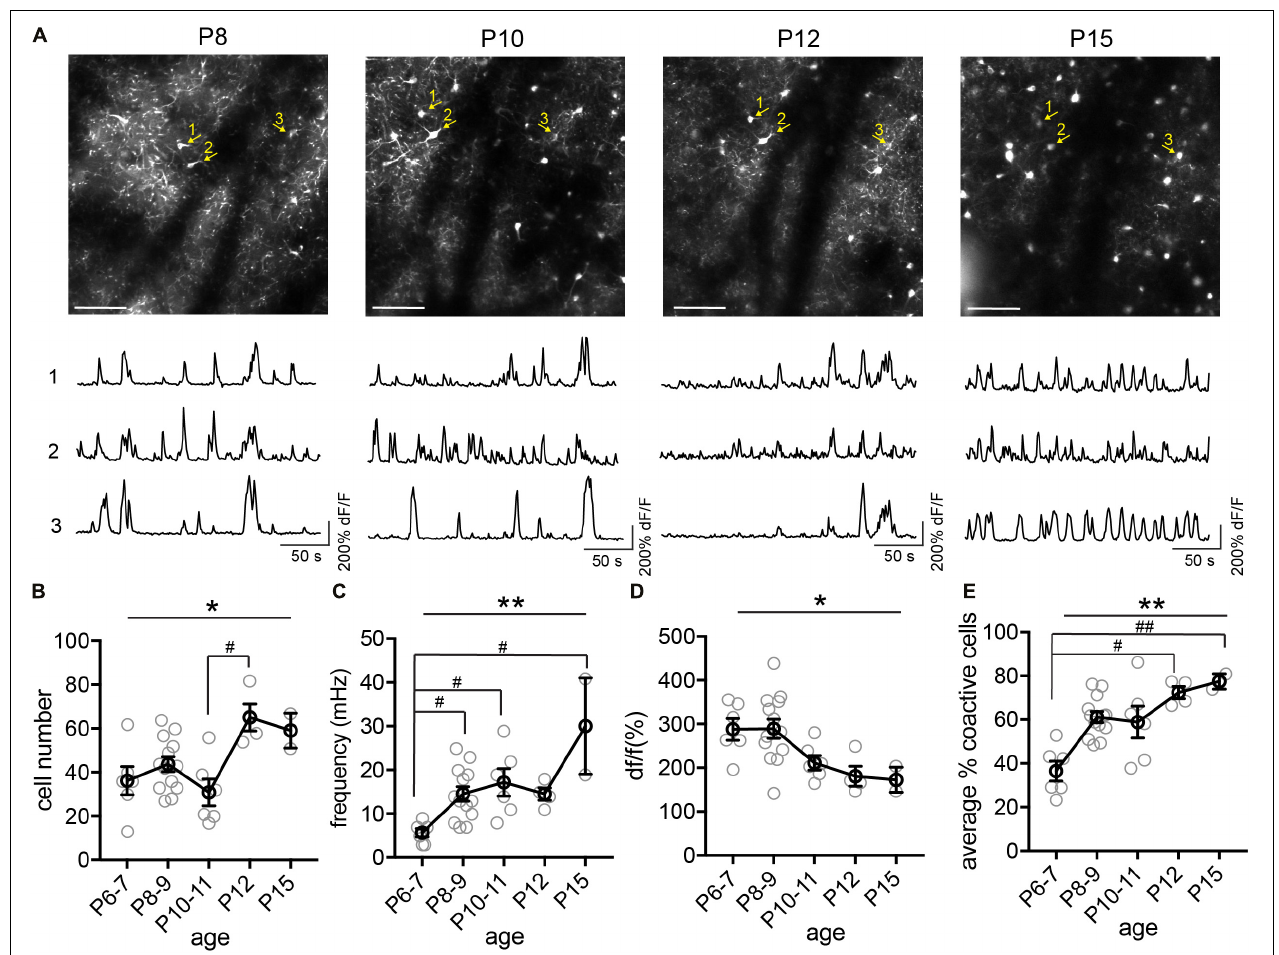
FIGURE 5 | Longitudinal imaging of VIP interneurons. (A) The same two-photon FOV from a VIP.GCaMP6s mouse at P8, P10, P12, and P15. Scale = 100 µ m. The same example cells across different ages are indicated by numbered yellow arrows. Corresponding raw (cid:49) F/F traces are shown below each FOV. (B) Quantification of the number of active cells in a FOV at P6–7, P8–9, P10–11, P12, and P15. Kruskal–Wallis test, * p = 0.016. n = 6 FOVs for P6–7, 13 FOVs for P8–9, 6 FOVs for P10–11, 4 FOVs for P12, and 2 FOVs for P15, from five animals. (C) Quantification of the average event frequency for each cell. ** p = 0.0061. (D) Quantification of the average event amplitude for each cell. * p = 0.016. (E) Quantification of the average percentage of coactive cells. ** p = 0.028. Black circles indicate mean from all videos; gray circles indicate individual videos; error bars indicate